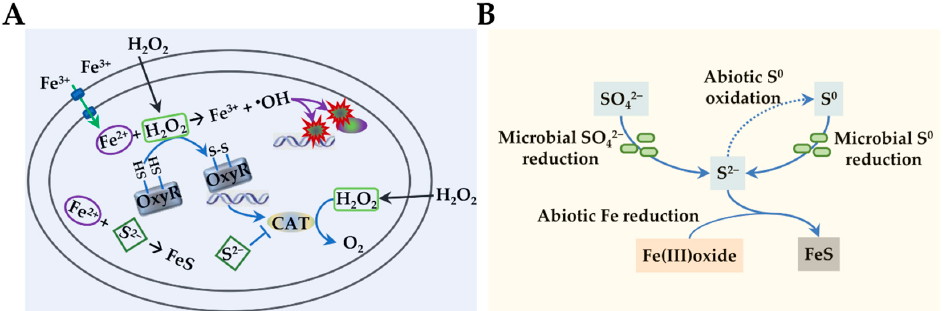
Figure 5. Physiological impacts of hydrogen sulfide. ( A ) H 2 S in oxidative stress. Upon oxidative stress, macromolecules such as DNA and proteins are damaged primarily by • OH, which is generated from the interaction of Fe 2+ and H 2 O 2 . H 2 S is a strong inhibitor of hemoproteins, catalase (CAT) in particular. With CAT inhibited, cells are unable to promptly decompose H 2 O 2 , leading to increased sensitivity to H 2 O 2 killing. However, the prolonged presence of H 2 O 2 activates OxyR, the master regulator in response to oxidative stress, which in turn induces expression of genes under its control, including CAT. As a result, cells gain an increased resistance against H 2 O 2 . In addition, it has been suggested that H 2 S from endogenous and exogenous sources may offer protection against oxidative stress by sequestering free Fe 2+ intracellularly. ( B ) H 2 S in metal reduction. Micro- bial reduction of SO 42 − and elemental S 0 to S 2 − , which catalyzes abiotic reduction of Fe 3+ of Fe(III)oxide and forms FeS with the resulting Fe 2+ . Interestingly, the combinatorial redox action of H 2 S and H 2 O 2 that promotes cytotox- icity is just one side of the story. A contrasting effect has been seen, even if the timing of